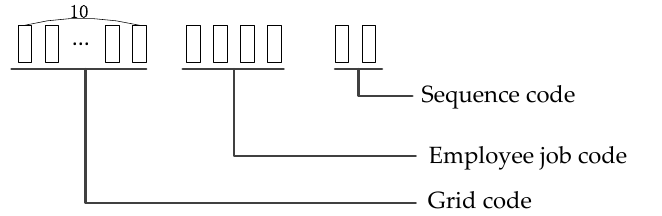
Figure 3. Code structure of the grid elements in the railway transportation system.